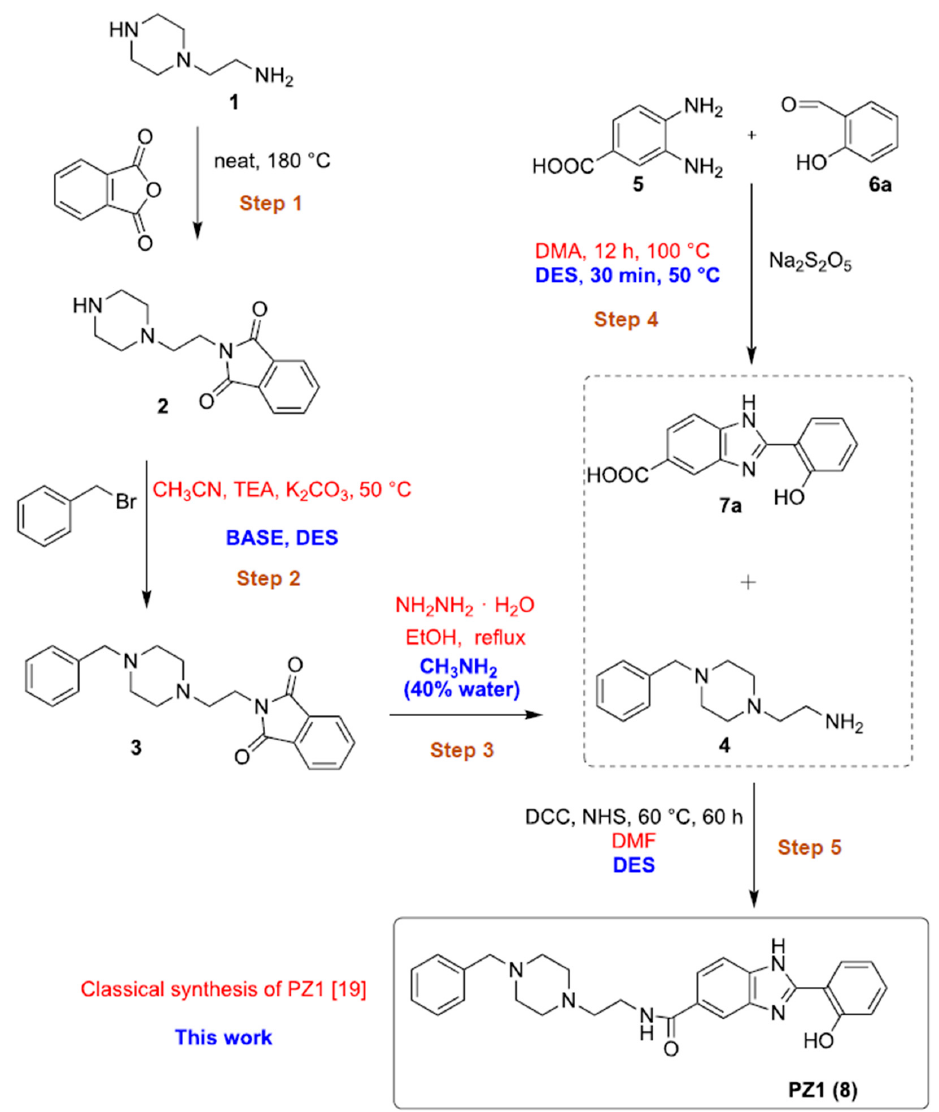
Figure 1. Classical [red, 19] and new green (blue) procedure for the synthesis of PZ1.